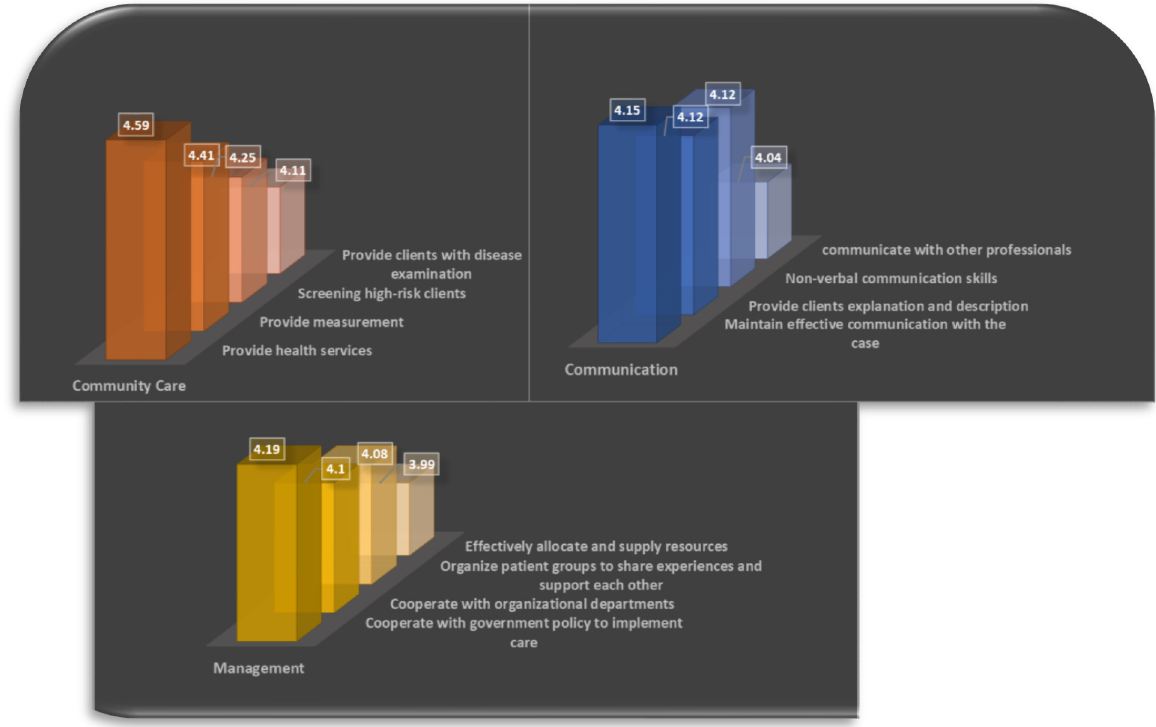
Figure 1. Analysis of community care nursing competence ( n = 197).